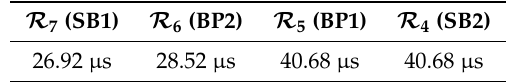
Table 8. Worst-case response times obtained by the analytical model with VLANs.